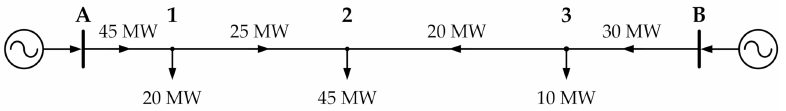
Figure 2. Natural active power flow in the analyzed network (base case power flow).